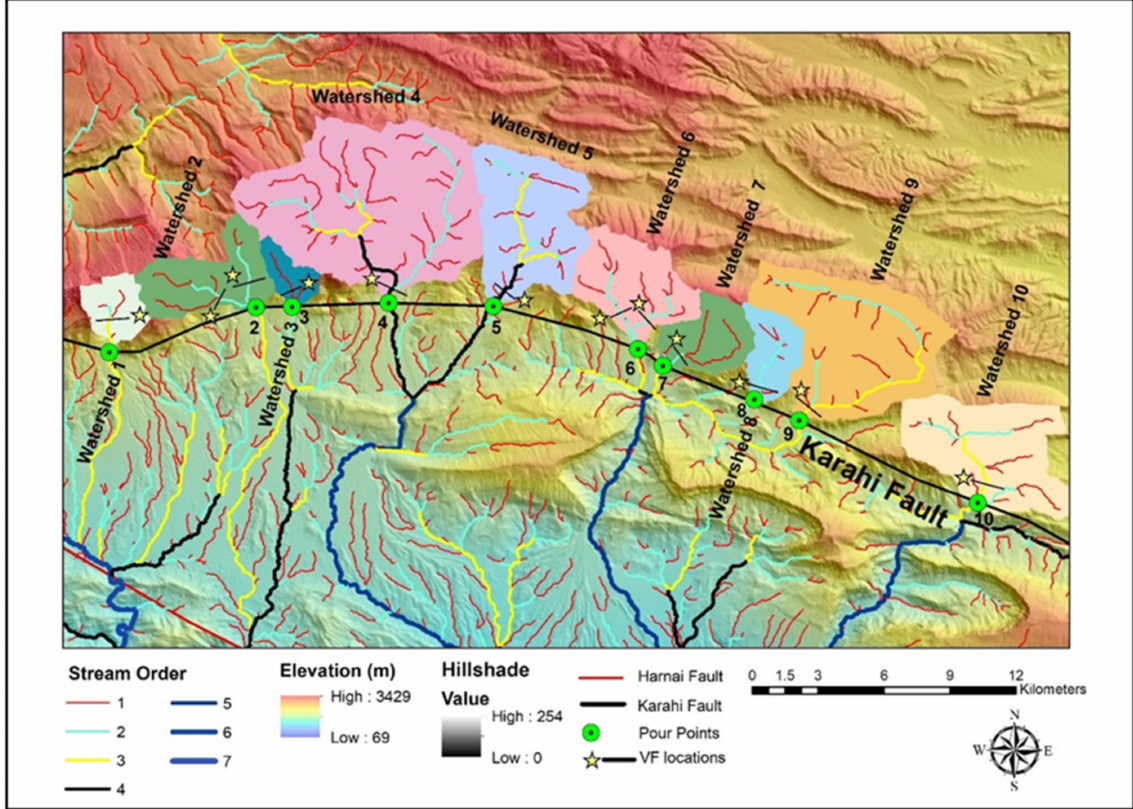
Figure 14. Hillshade map with stream order for Karahi Fault. The colored areas show the watersheds numbered from 1 to 14, while the green circle represents the location of the pour points. The black lines with stars display the location of the Vf